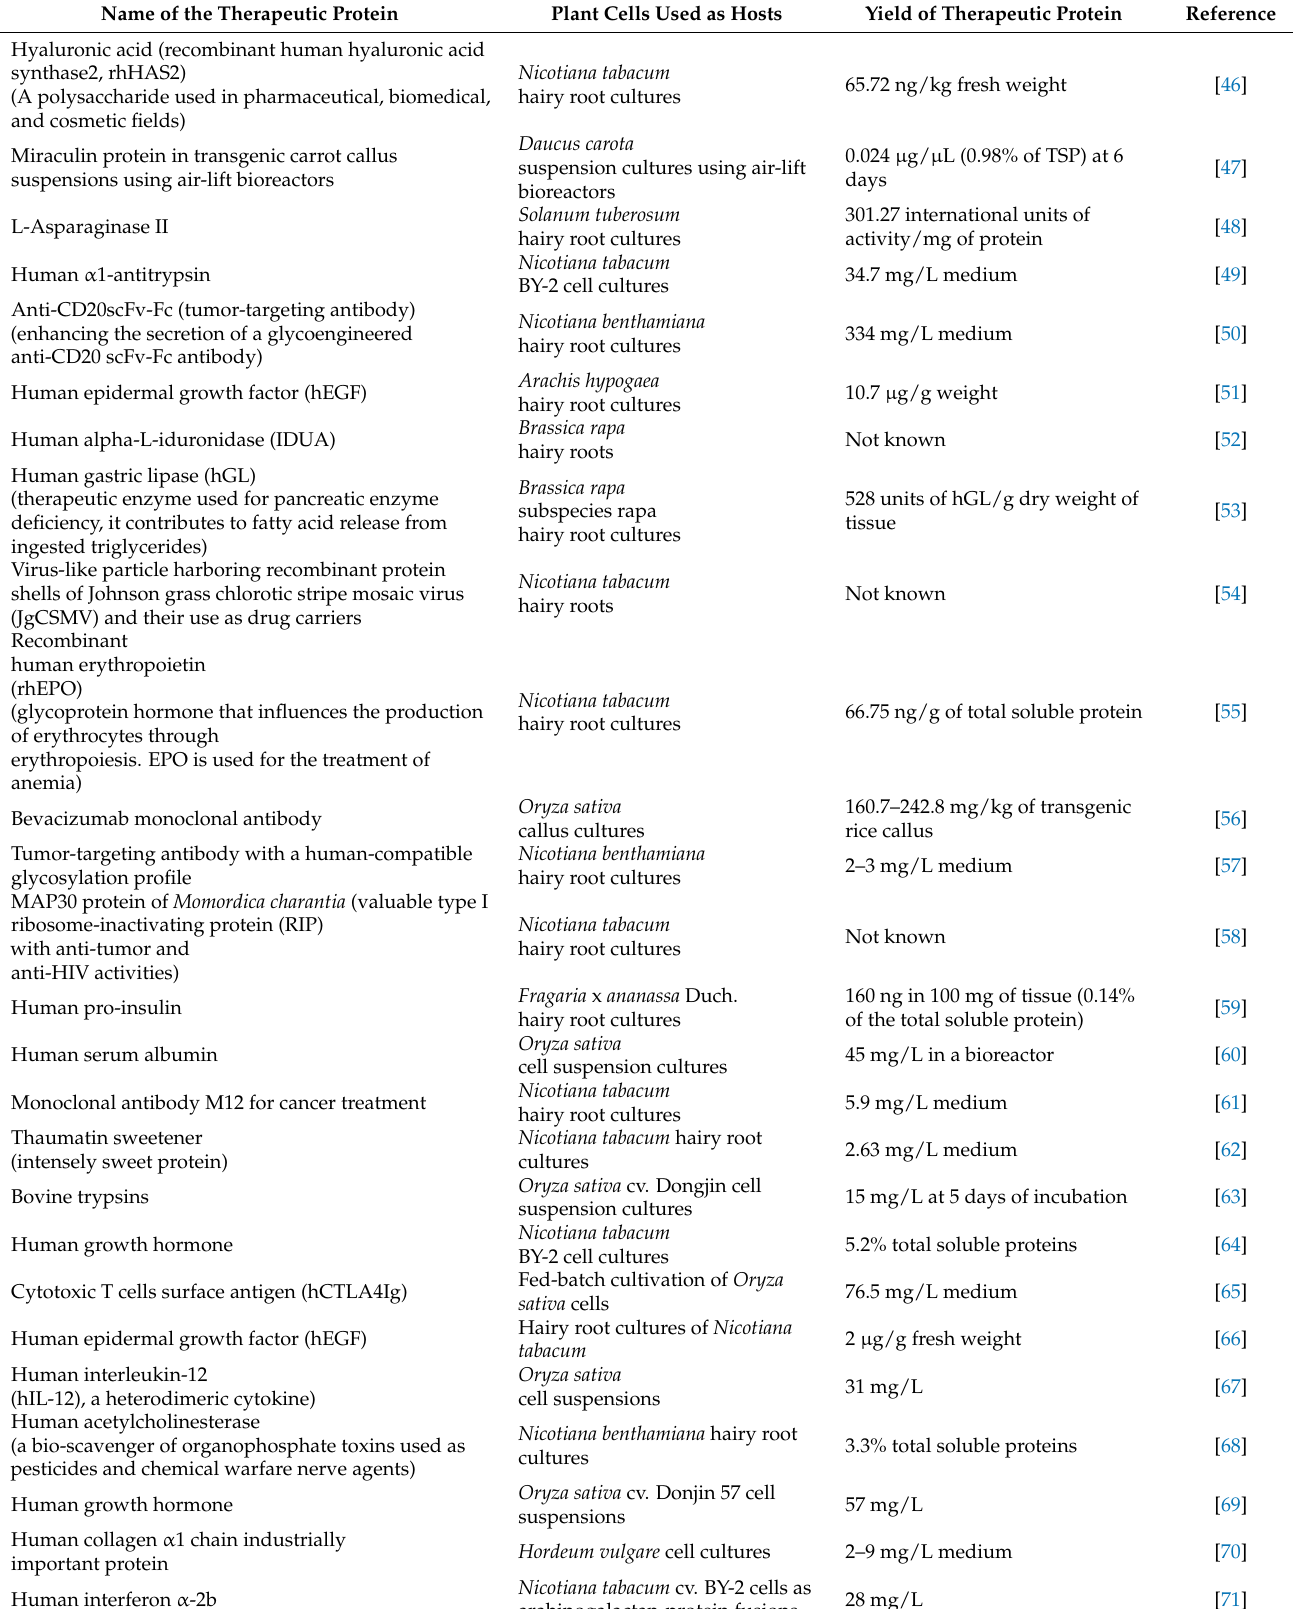
Table 1. Compendium on therapeutic proteins produced using plant cell cultures/hairy